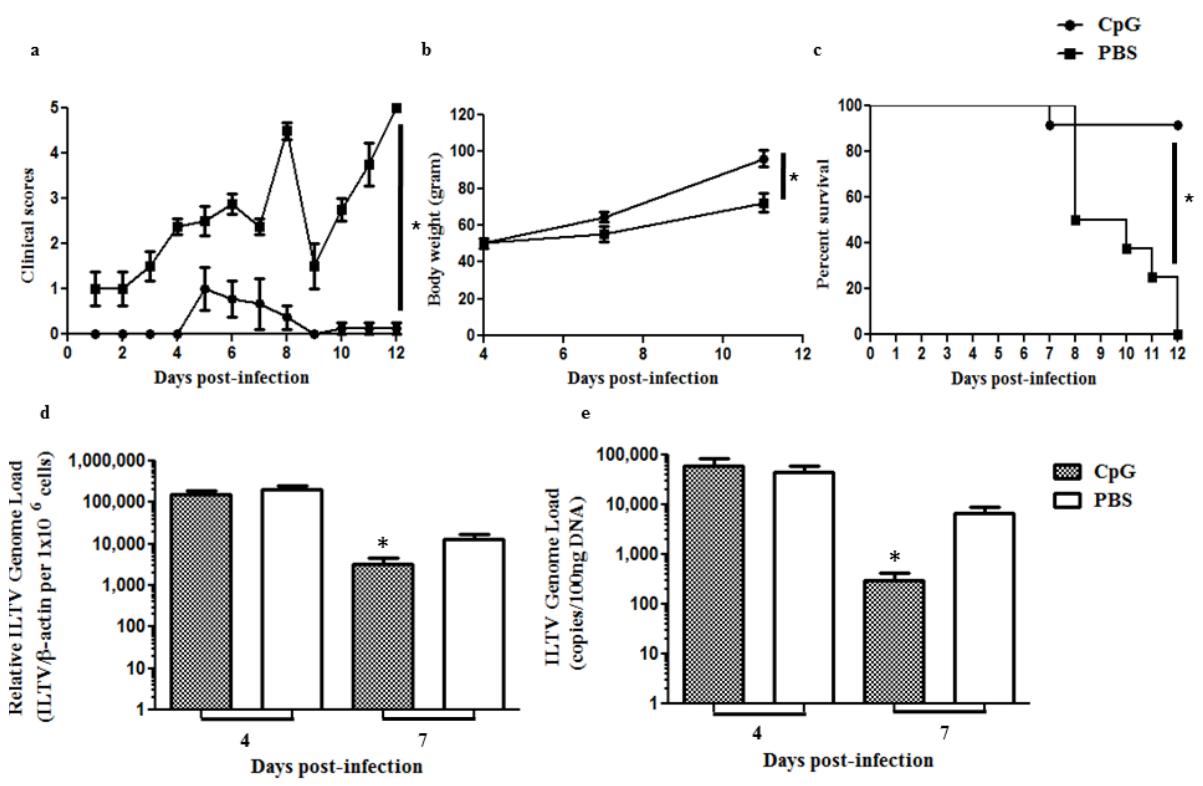
Figure 5. In ovo delivery of CpG DNA induces protection against ILTV caused morbidity and mortality reducing viral replication in the respiratory tract of chickens. SPF eggs were injected with CpG DNA or PBS in ovo , allowed to hatch and hatched chickens were infected with 5 × 10 4 PFU of ILTV intratracheally. The infected chickens were observed for 12 days post-infection for development of clinical signs and determination of the end points as has been described in the materials and methods section. The chickens were also weighed (4, 7 and 11 days post-infection) and tracheal swabs (4 and 7 days post-infection) were collected for quantification of ILTV PK gene mRNA expression and genome load using real-time RT-PCR technique. ( a ) clinical scores; ( b ) bodyweights; ( c ) survival proportions, ( d ) ILTV PK gene mRNA expression as assessed in tracheal swabs using cDNA as template and ( e ) ILTV genome load in tracheal swabs using DNA as template. * indicates the significant differences between groups at p <